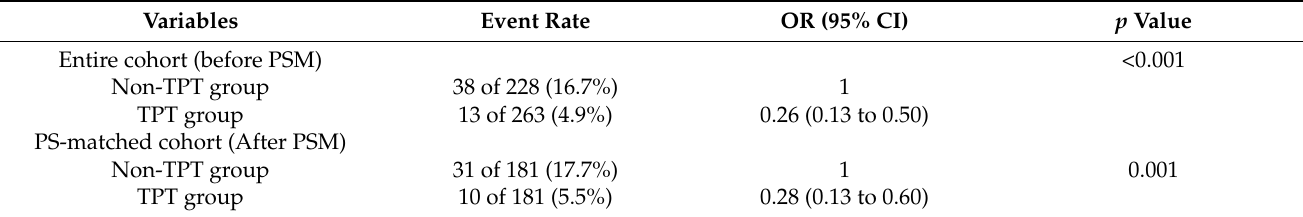
Table 2. Postoperative neurological complications after surgical clipping of UIA before and after propensity score matching.